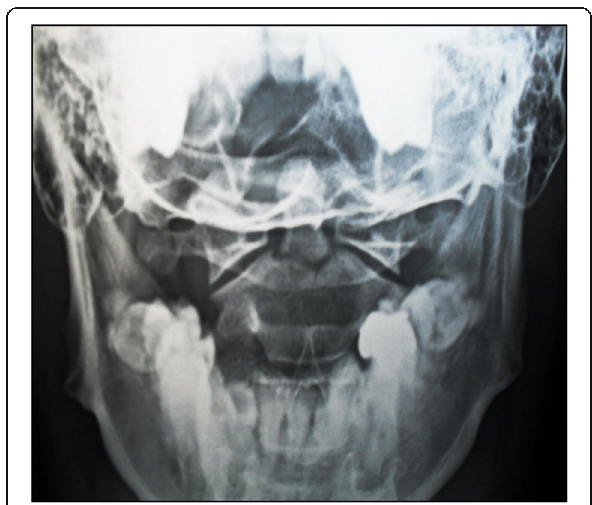
Fig. 2 X-ray shows odontoid view of odontoid fracture type